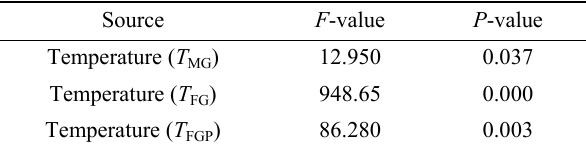
Table 5 ANOVA for the dependent variables of the three types of rock samples.